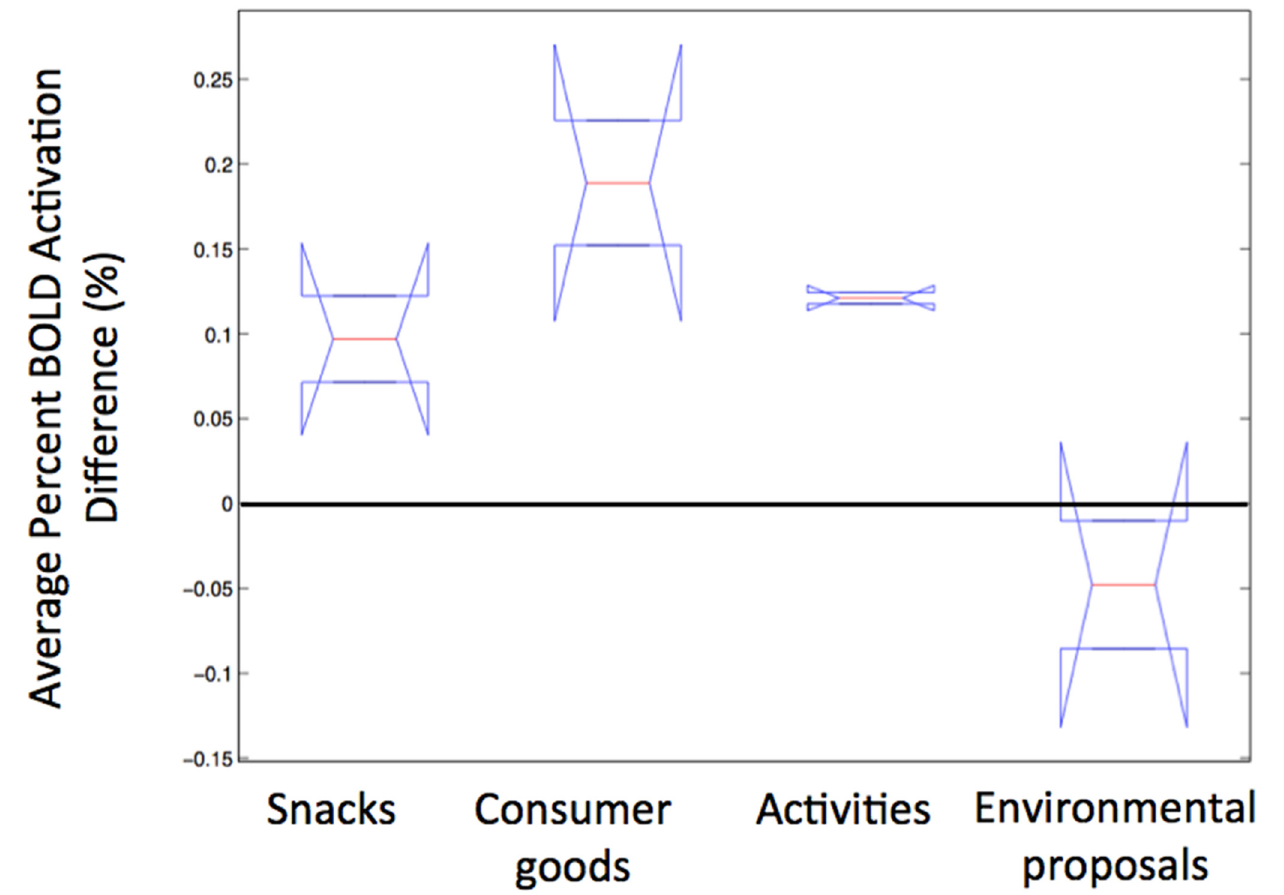
Fig 7. Boxplot of average differences in activation between most and least preferred goods across all four categories of goods. Group averages were computed from differences in vmPFC BOLD activation between most and least preferred goods (i.e., differences in average percent BOLD change within time points 3, 4, and 5 or, alternatively, 6 – 10 s after stimulus onset) for each subject within each good category. A one-way ANOVA performed across the groups suggests that the between-group means to be significantly different (F = 11.58, p < 0.05). Excluding the environmental proposals eliminates this effect (F = 3.41, p > 0.1), suggesting that the remaining three group means are not significantly different from each